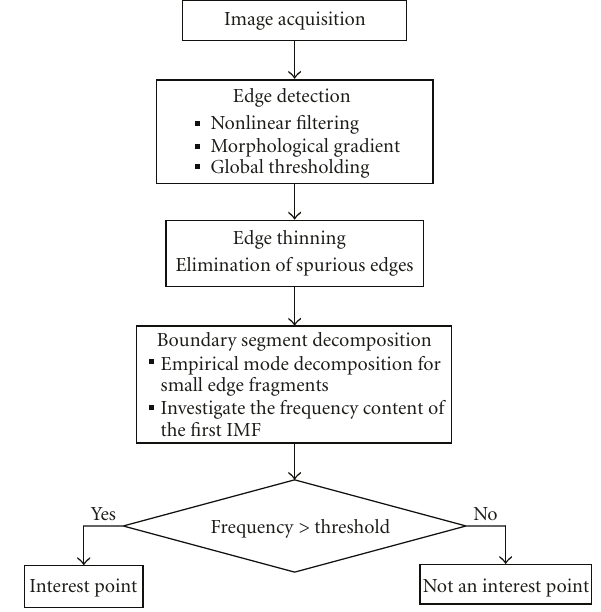
Figure 1: Block diagram of the proposed